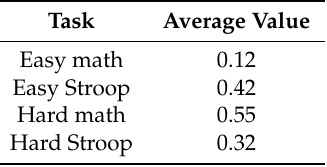
Table 3. Average differences between the normalized VAS scores before and after each task. Here, the relaxation tasks were used as a baseline before stressor